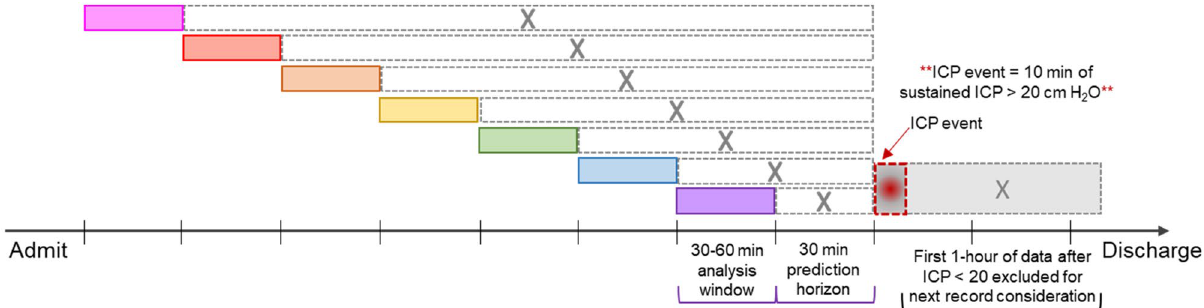
Figure 1. Elevated ICP event schematic. The prediction horizon is the time prior to the ICP event over which features from the preceding analysis window are used for prediction. ICP had to remain < 20 cm H 2 O for one hour before subsequent data could be considered for